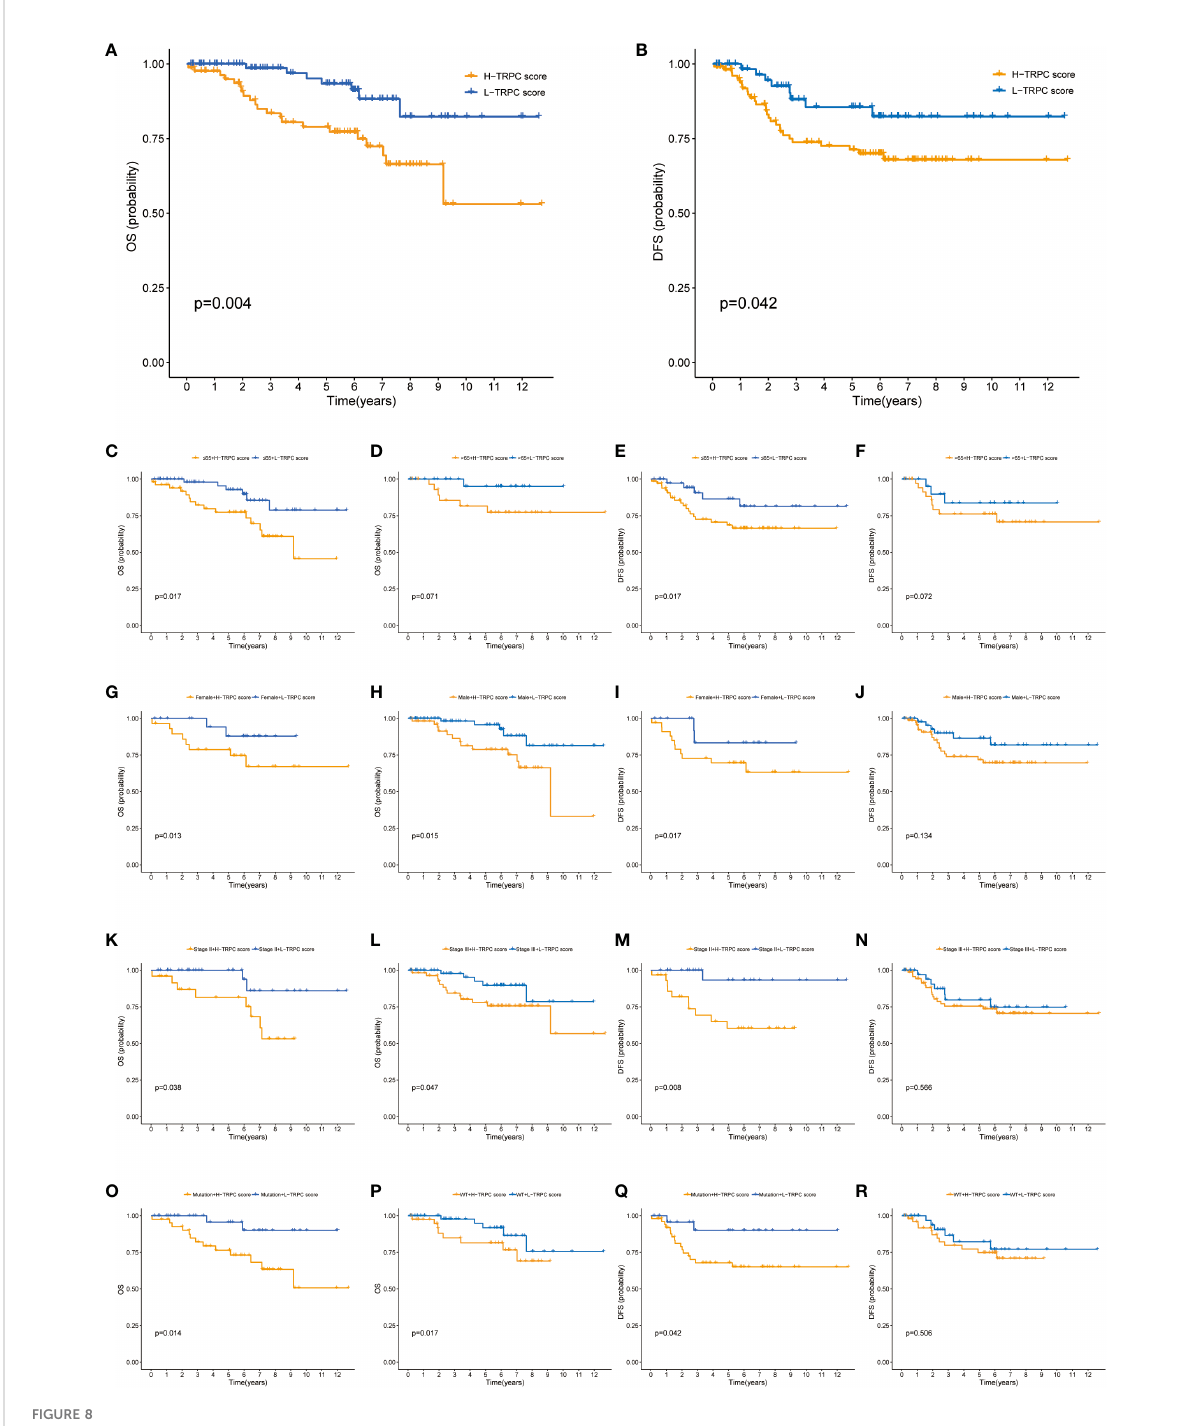
FIGURE 8 Correlation between TRPC score and prognosis of patients who received NCRT in the GSE87211 cohort. (A) The Kaplan-Meier curves of OS for patients in the high- and low-TRPC score groups. The Kaplan-Meier curves of OS for supplement clinicopathological characteristics, including age (C, D) , gender (G, H) , stage (K, L) , and KRAS mutation status (O, P) in the high- and low-TRPC score groups. (B) The Kaplan-Meier curves of DFS for patients in the high- and low-TRPC score groups. The Kaplan-Meier curves of DFS for supplement clinicopathological characteristics, including age (E, F) , gender (I, J) , stage (M, N) , and KRAS mutation status (Q, R) in the high- and low-TRPC score groups. NCRT, neoadjuvant chemoradiotherapy; OS, overall survival; TRPC, transient receptor potential